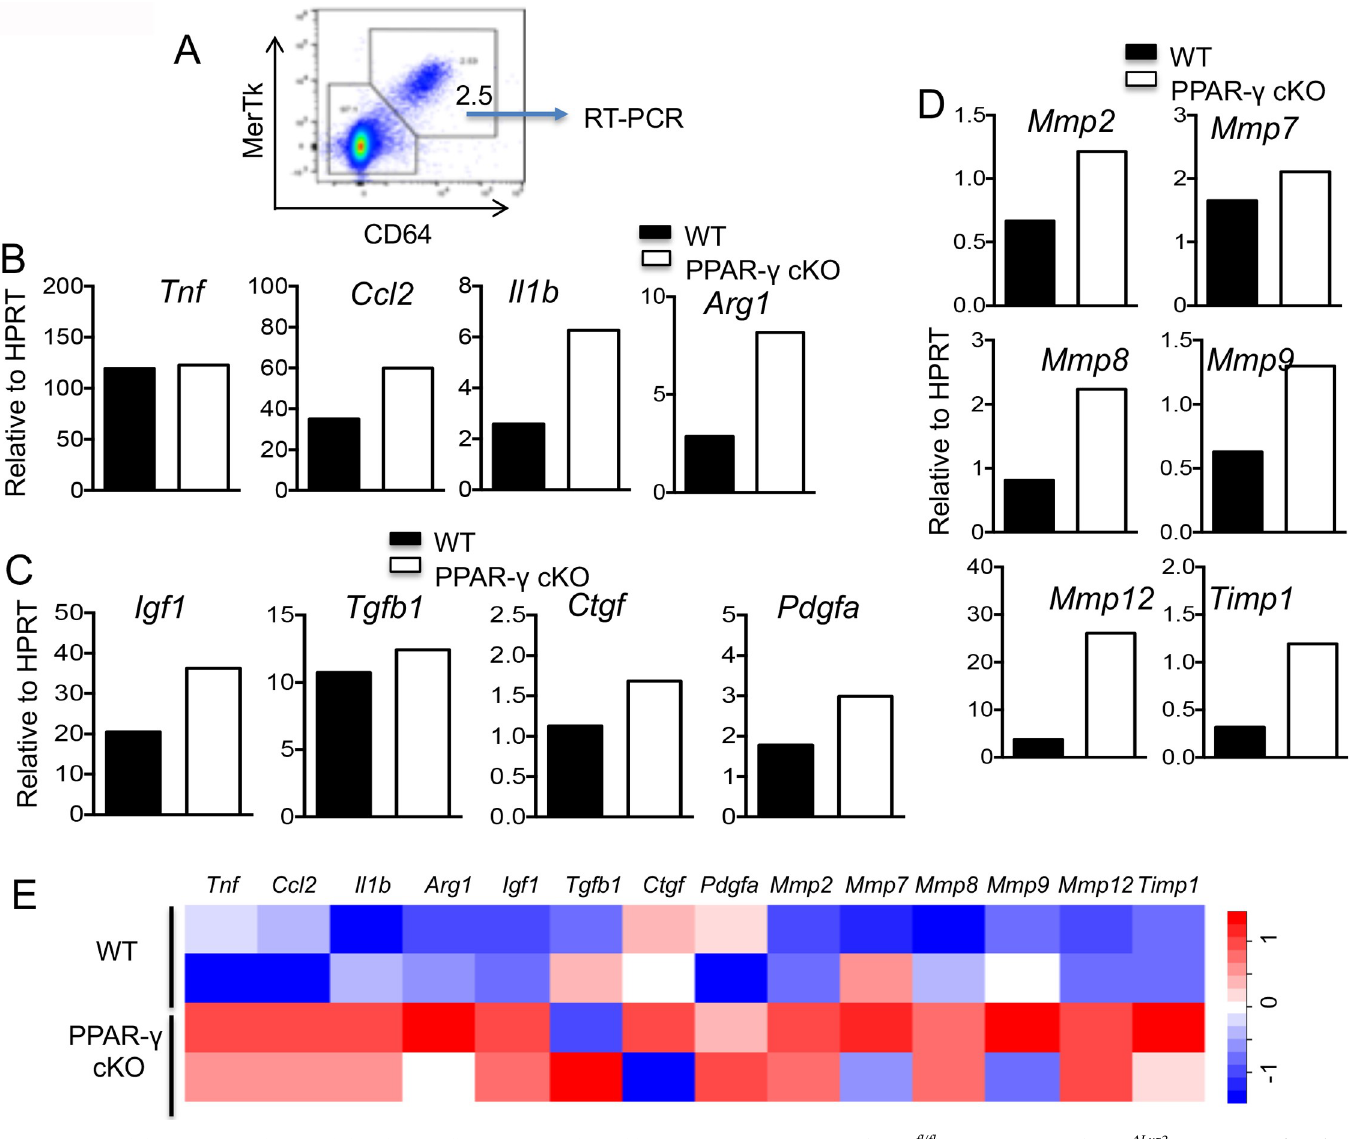
Fig 2. PPAR- γ deficient macrophages exhibited pro-inflammatory and pro-fibrotic gene expression. WT ( Pparg fl/fl ) or PPAR- γ cKO ( Pparg Δ Lyz2 ) mice were infected with influenza. Mice were sacrificed for macrophage isolation at 30 d.p.i. ( A ) Lung cells were stained with anti-CD45, anti-Ly6G, anti-MerTK and anti-CD64. MerTK + / CD64 + lung macrophages in CD45 + Ly6G - cells were sorted by flow cytometry for realtime RT-PCR analysis of gene expression. ( B ) Expression of Tnf , Ccl2 , Il1b and Arg1 in lung macrophages (isolated from pooled 3–4 mice/group/experiment) by realtime RT-PCR. ( C ) Expression of growth factors Igf1 , Pdgfa , Tgfb and Ctgf in sorted lung macrophages (isolated from pooled 3–4 mice/group/experiment) by realtime RT-PCR. ( D ) Expression of several tissue remodeling enzymes and fibrotic genes Mmp2 , Mmp8 , Mmp12 , Mmp7 , Mmp9 and Timp1 in sorted lung macrophages (isolated from pooled 3–4 mice/group/experiment) by realtime RT-PCR. ( E ) Heat-map expression of the pro-inflammatory and profibrotic genes shown in B-D in lung alveolar macrophages from adult WT or conditional PPAR- γ -deficient mice ( Pparg Δ CD11c ) in published microarray dataset (GSE60249). Data are representative of two independent experiments of pooled lung macrophages from 3–4 mice except ( E ).